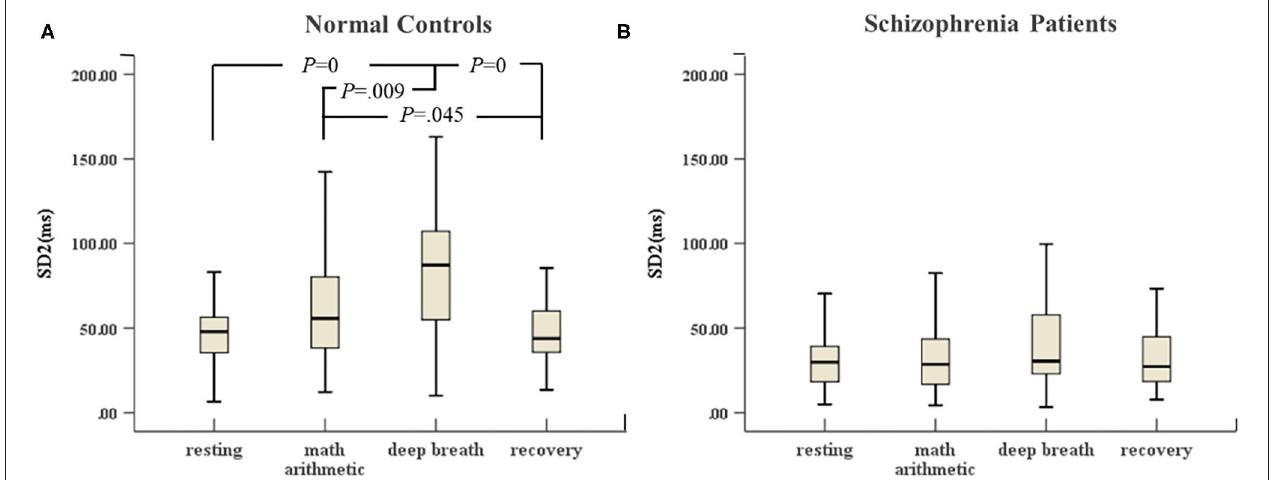
FIGURE 5 | (A) SD2 of HRV of normal controls ( n = 45) and (B) SD2 of HRV of schizophrenia patients ( n = 45) during the ANS test, which was analyzed with ANOVA, p <